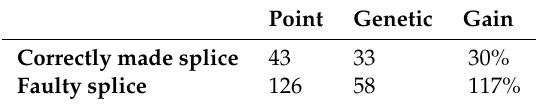
Table 1. RMS errors between shift vector and its linear approximation function. Point Genetic